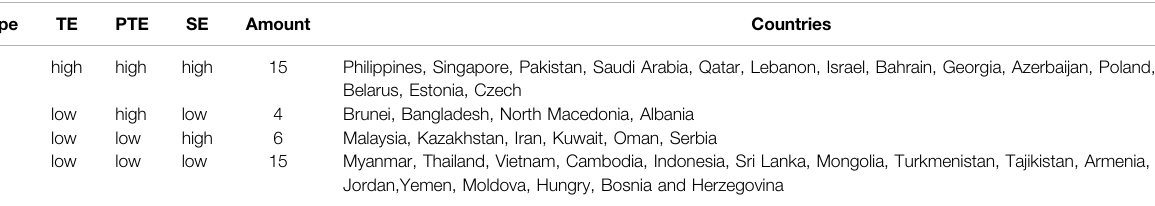
TABLE 6 | Types of green investment ef fi ciencies.